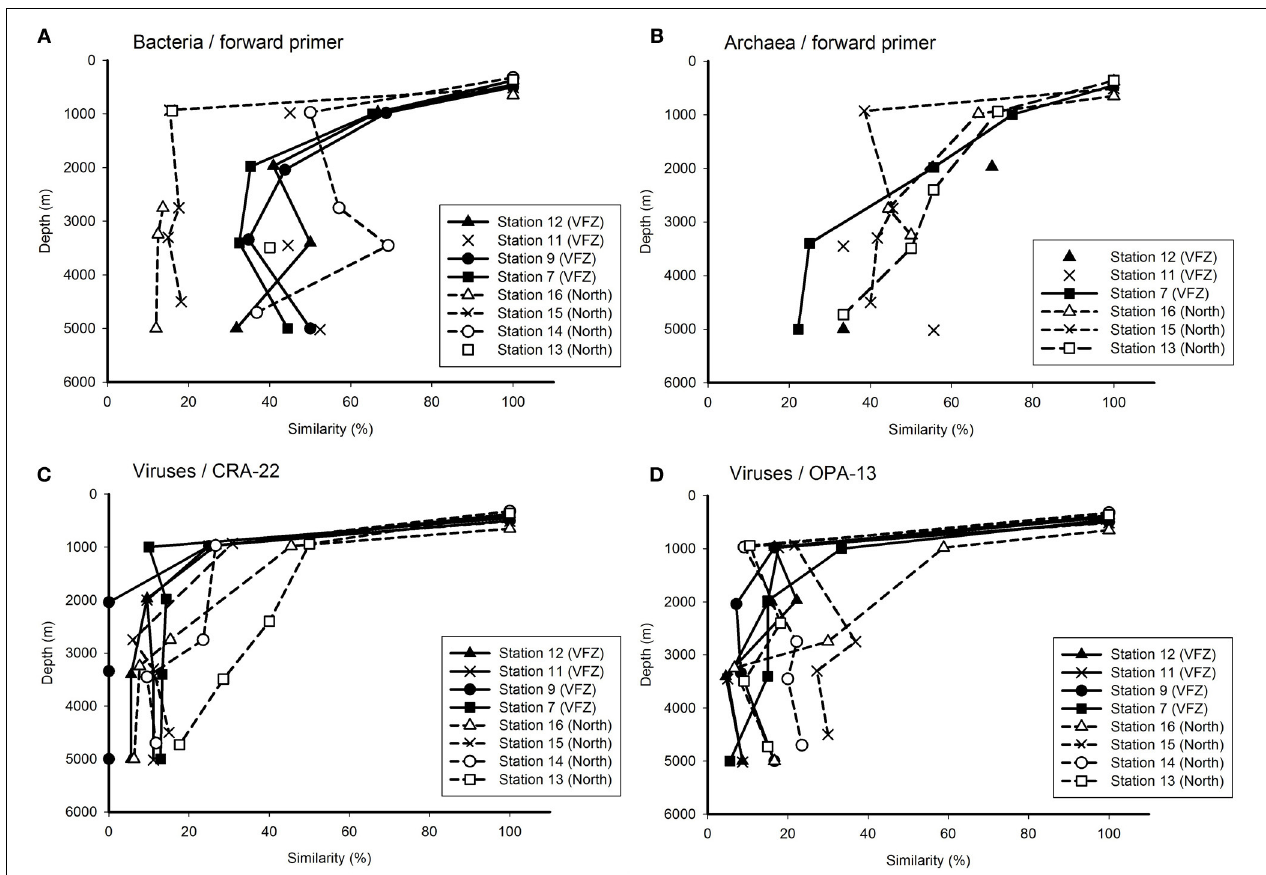
FIGURE 4 | Relationship between depth and Jaccard similarity of the bacterial (A), archaeal (B), and viral (C,D) community north and inside the Vema Fracture Zone (VFZ) in the (sub)tropical North Atlantic Ocean.